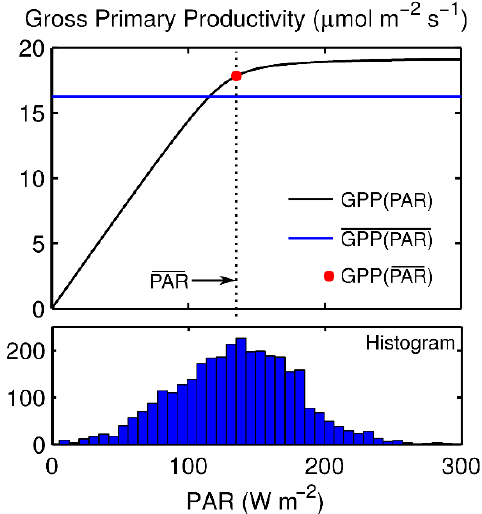
Figure 1. Application of kriged shortwave radiation (i.e., PAR) to estimate gross primary productivity (GPP) over a 2.5 ◦ longitude × 2.5 ◦ latitude region (~220 km) in central Oklahoma. The black curve illustrates the nonlinear relationship between GPP and PAR from a canopy model. The histogram shows the distribution of PAR values within the region on May 30 of 2006 (16:00–6:30 local time). Due to the saturation of GPP at high PAR, estimates of GPP from the spatially-averaged PAR (red circle) are higher than the actual regional-scale GPP (blue line).